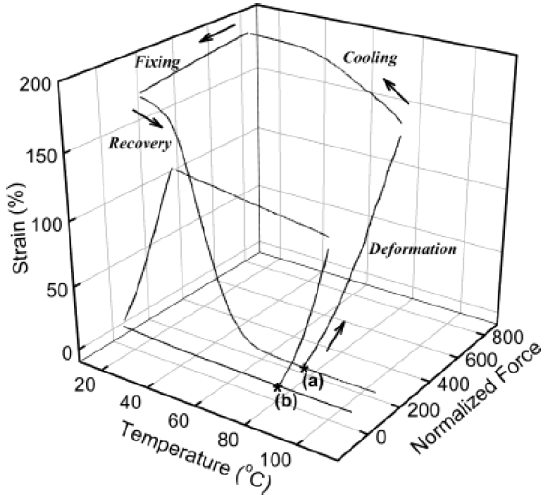
Figure 4. The complete shape memory cycle in a smectic-C (SmC) polydomain main chain liquid crystal elastomer (MCLCE) obtained from dynamic mechanical analysis. Case ( a ) is for the SmC polydomain MCLCE and ( b ) the case of isotropic rubber where no “fixing” of secondary shape is observed. Adapted with permission from [7]. Copyright 2003 American Chemical